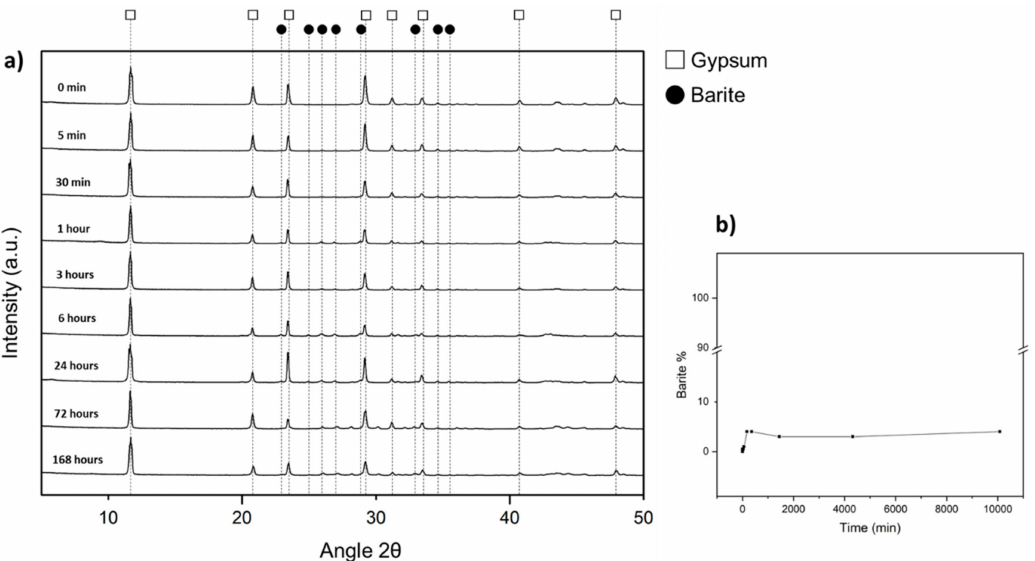
Figure 6. X-ray di ff raction patterns of gypsum crystals after di ff erent times of interaction with a 0.5 M Ba-bearing aqueous solution. ( a ) Di ff raction peaks corresponding to barite are absent in the di ff ractograms of gypsum samples interacted with the 0.5 M Ba-bearing aqueous solution during less than 30 min and are scarce and very weak in the di ff ractograms of all the samples that interacted longer times, indicating that gypsum barely transforms into barite regardless of the length of the interaction. After one week of interaction, the barite content of the gypsum sample barely amounts for 5 wt% ( b ) Newly formed barite content of the gypsum interacted samples, calculated from RIR analyses of XRD data, plotted against the interaction time.